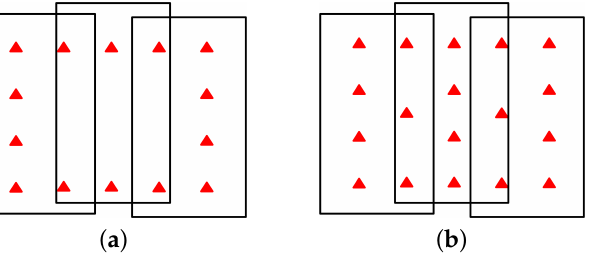
Figure 2. Ideal distribution pattern of GCPs: ( a ) Rectangular shape and ( b ) cross shape; red triangles represent